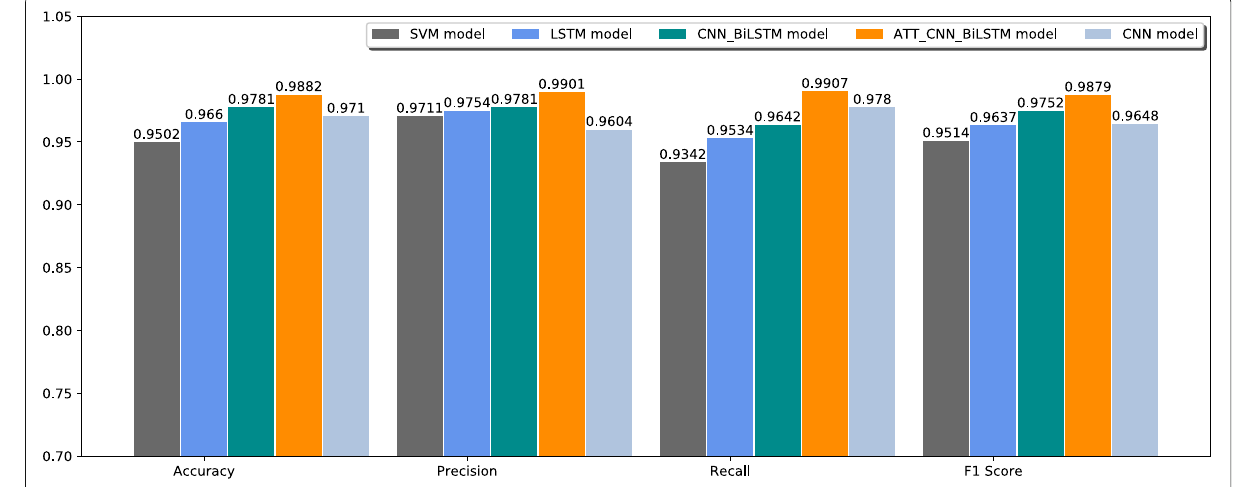
the local features and long-distance dependence informa- tion within the domain name sequences.